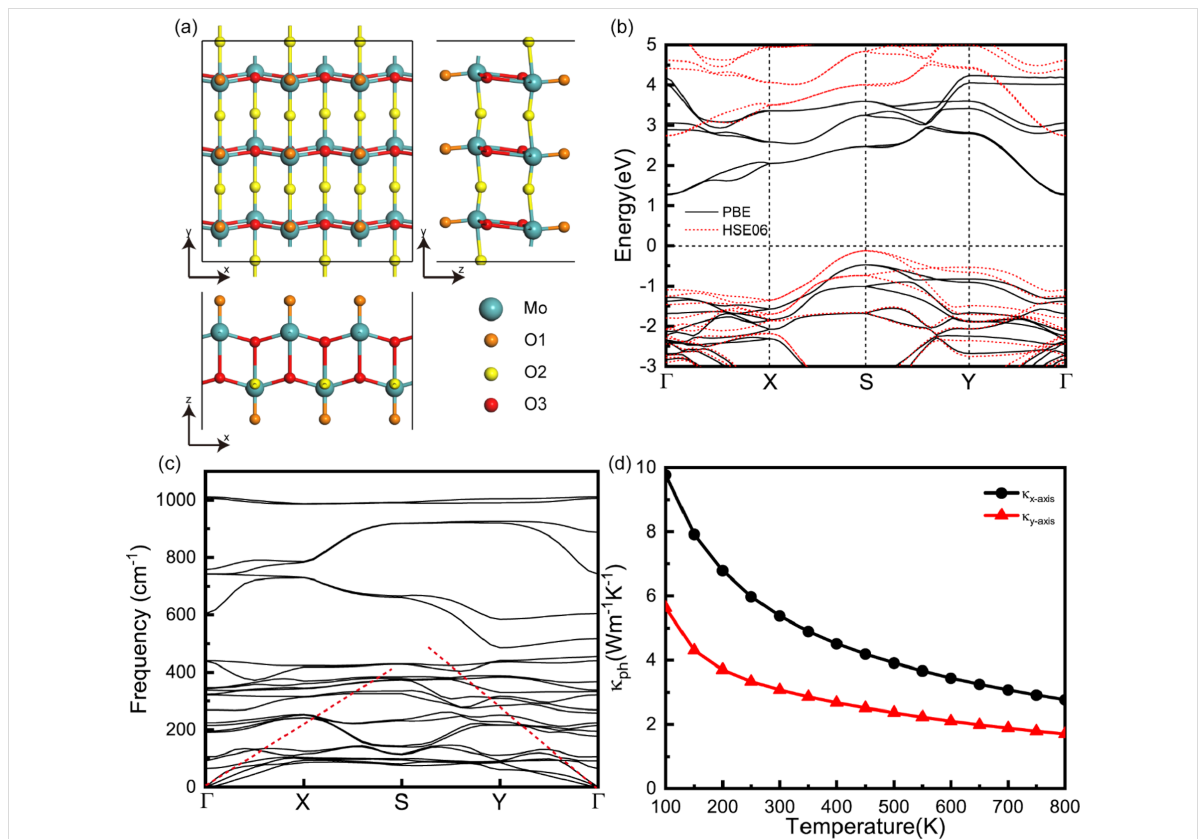
Figure 1: (a) Crystal structures of the MoO 3 monolayer (3 × 3 × 1 supercell): top and side views. (b) The electronic band structure and (c) the phonon dispersion of the MoO 3 monolayer along the high-symmetry path. (d) The lattice thermal conductivity, κ ph , of the MoO 3 monolayer along different directions as a function of